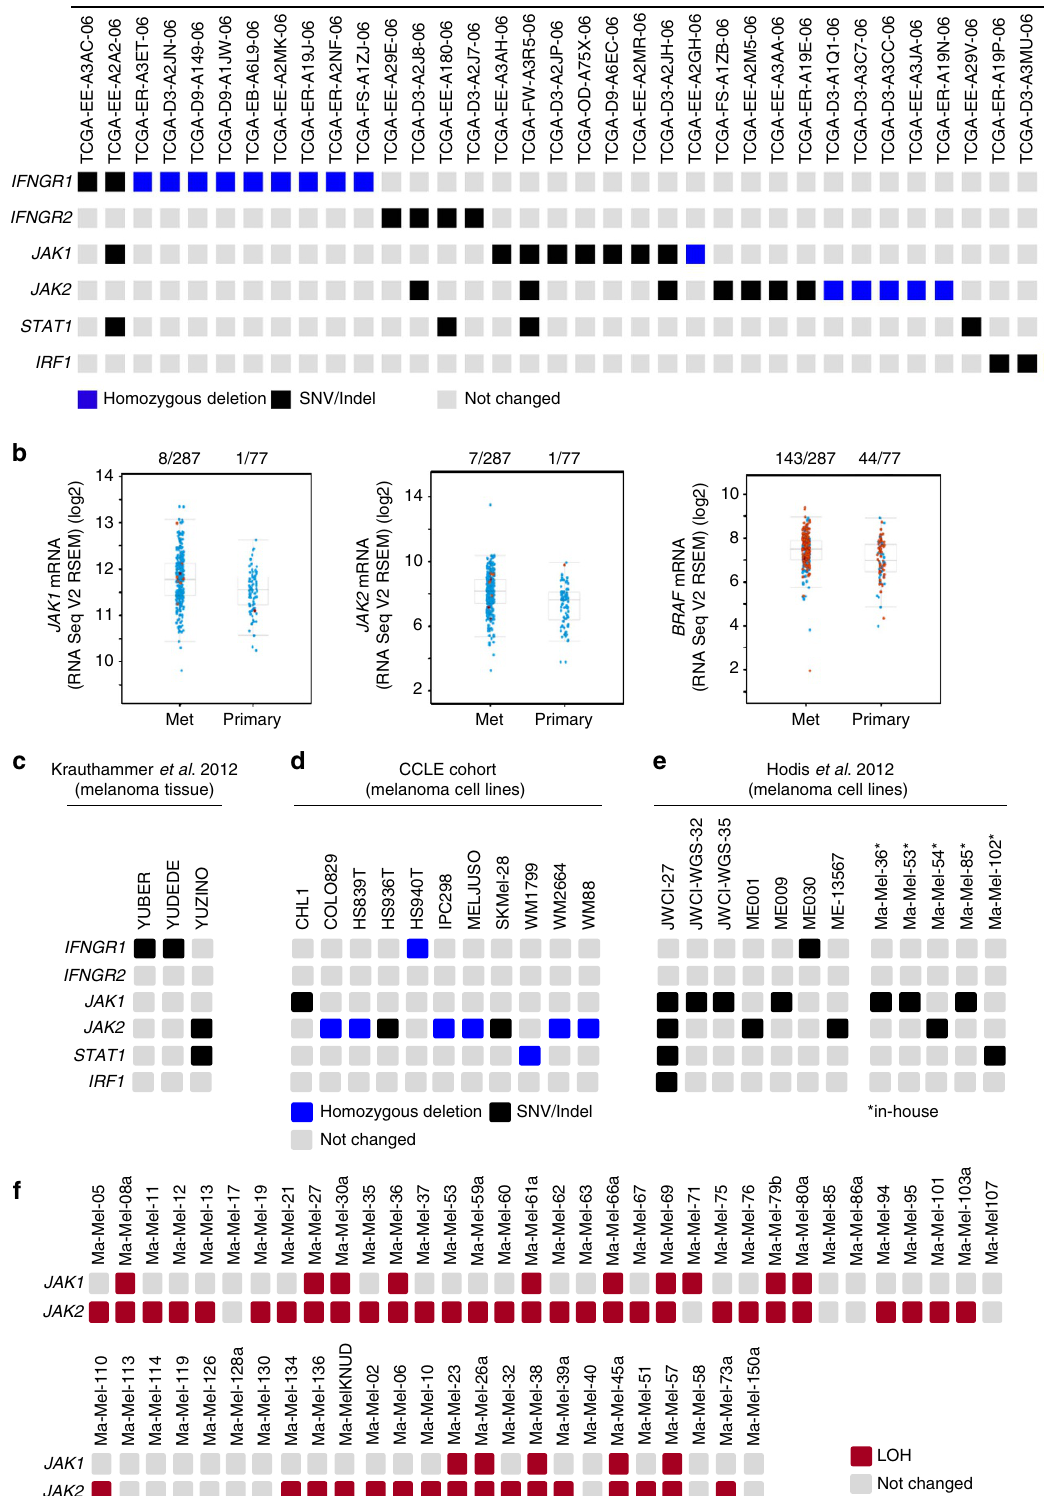
NATURE COMMUNICATIONS|8:15440|DOI: